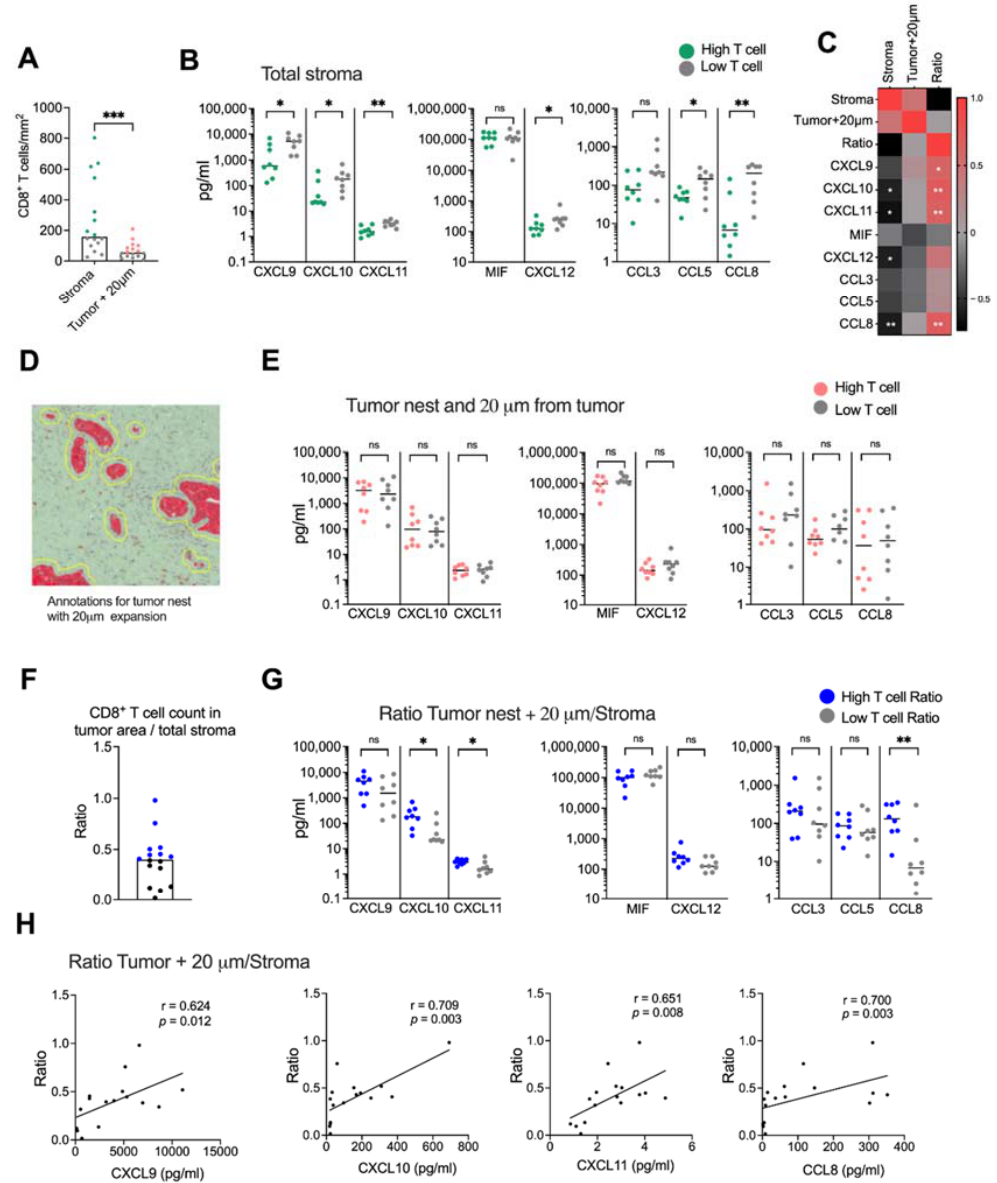
Figure 5. Spatial localization of CD8 + T cells. ( A ) Number of CD8 + T cells in stroma and in the tumor nest with 20 μ m expansion from the tumor nests. Green and red dots show the donors with CD8 + T cells numbers above the median and gray dots show the donors with CD8 + T cell numbers below the median. ( B ) Secretion of chemokines in tissues with high CD8 + T cell numbers (green) and low CD8 + T cell numbers (gray). ( C ) Heatmap correlation matrix showing positive (red) and negative (black) correlations between number of CD8 + T cells and chemokine secretion. ( D ) Annotations including both the tumor nests and 20 μ m from the tumor nests. ( E ) Secretion of chemokines in tissues with high CD8 + T cells numbers (red) and low CD8 + T cell numbers (gray) in the tumor nests + 20 μ m from the tumor nests. ( F ) Ratio between the number of CD8 + T cells in tumor nest + 20 μ m and the CD8 + T cell count in total stroma. ( G ) Secretion of chemokines in tissues with high CD8 + T cells ratio (blue) and low CD8 + T cell ratio (gray). ( H ) Correlations between the ratio of CD8 + T cells in tumoral areas (tumor nest + 20 μ m from tumor/total stroma) and CXCL9, CXCL10, CXCL11 and CCL8. Mann–Whitney test was used to detect statistically significant differences between unpaired samples. Correlations were evaluated by using Spearman’s correlation test. Spearman r and p ‐ val ‐ ues are presented. ns, not significant. * p < 0.05, ** p < 0.01, *** p < 0.001.